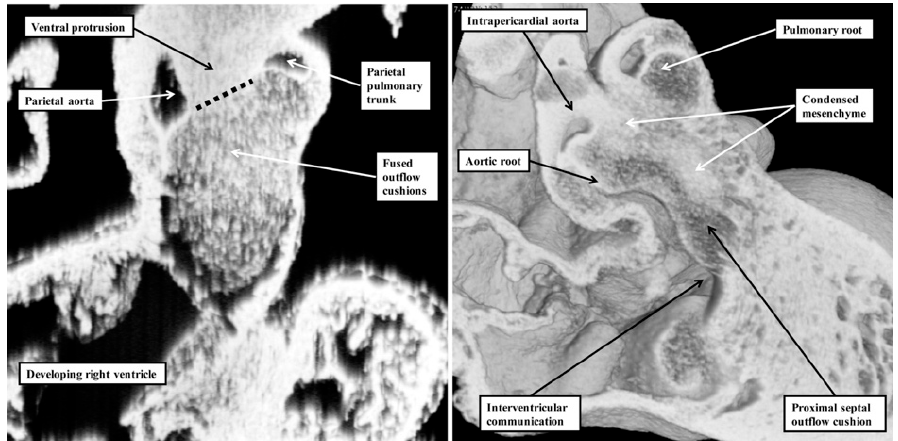
the “outflow tract septal